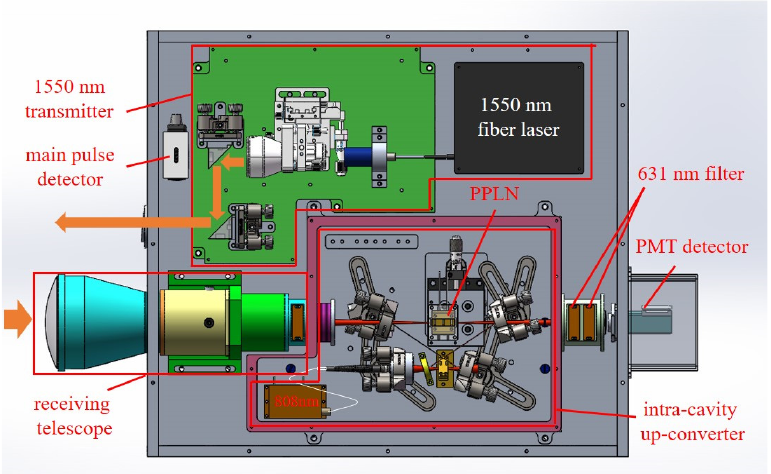
Figure 3. Experimental setup of the eye-safe aerosol lidar based on free-space intracavity upconver-